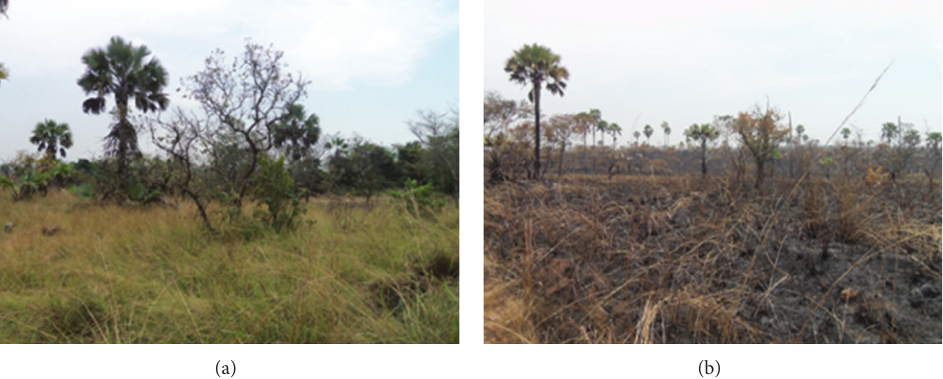
Figure 8: Overview of the vegetation at Lamto (a) before the bushfire in October 2011 and (b) after the bushfire in December